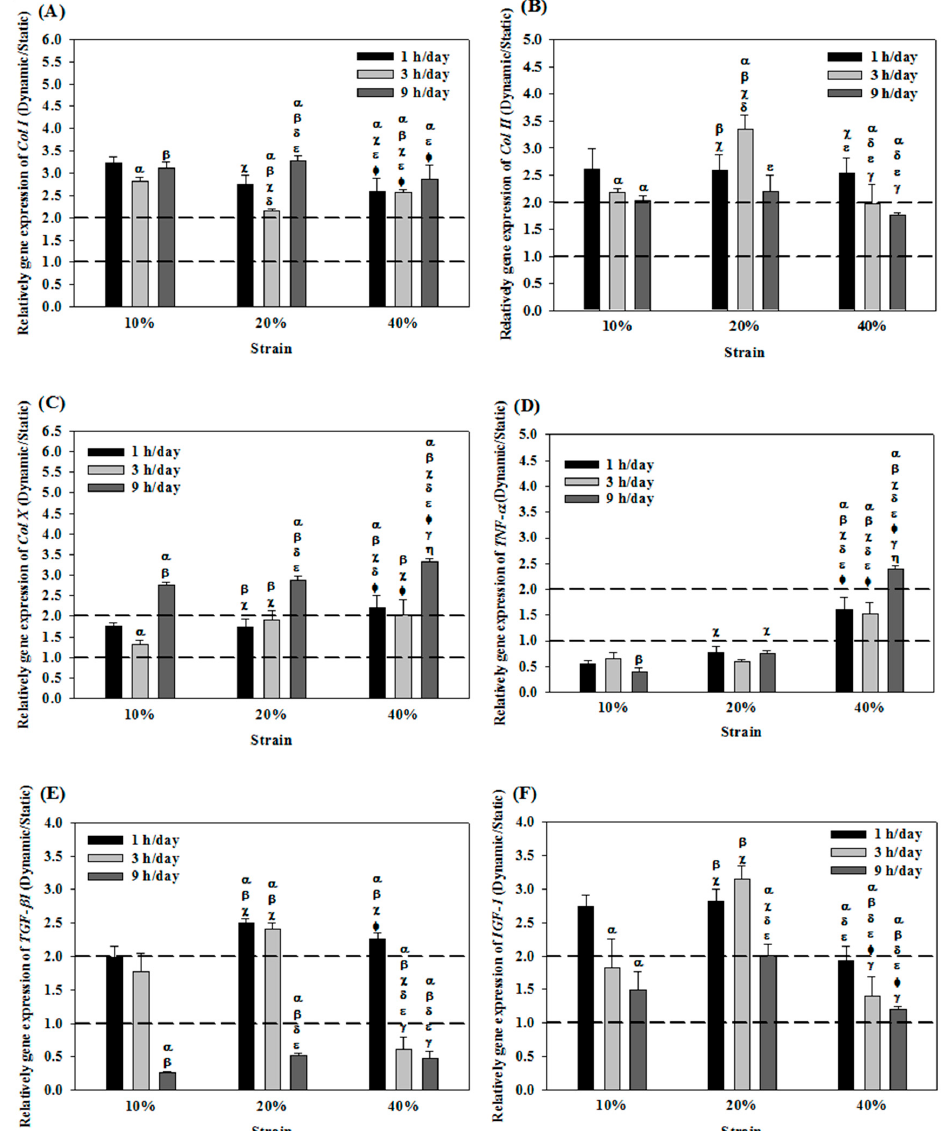
Figure 1. The relative gene expression when chondrocytes were cultured in cryogel scaffolds